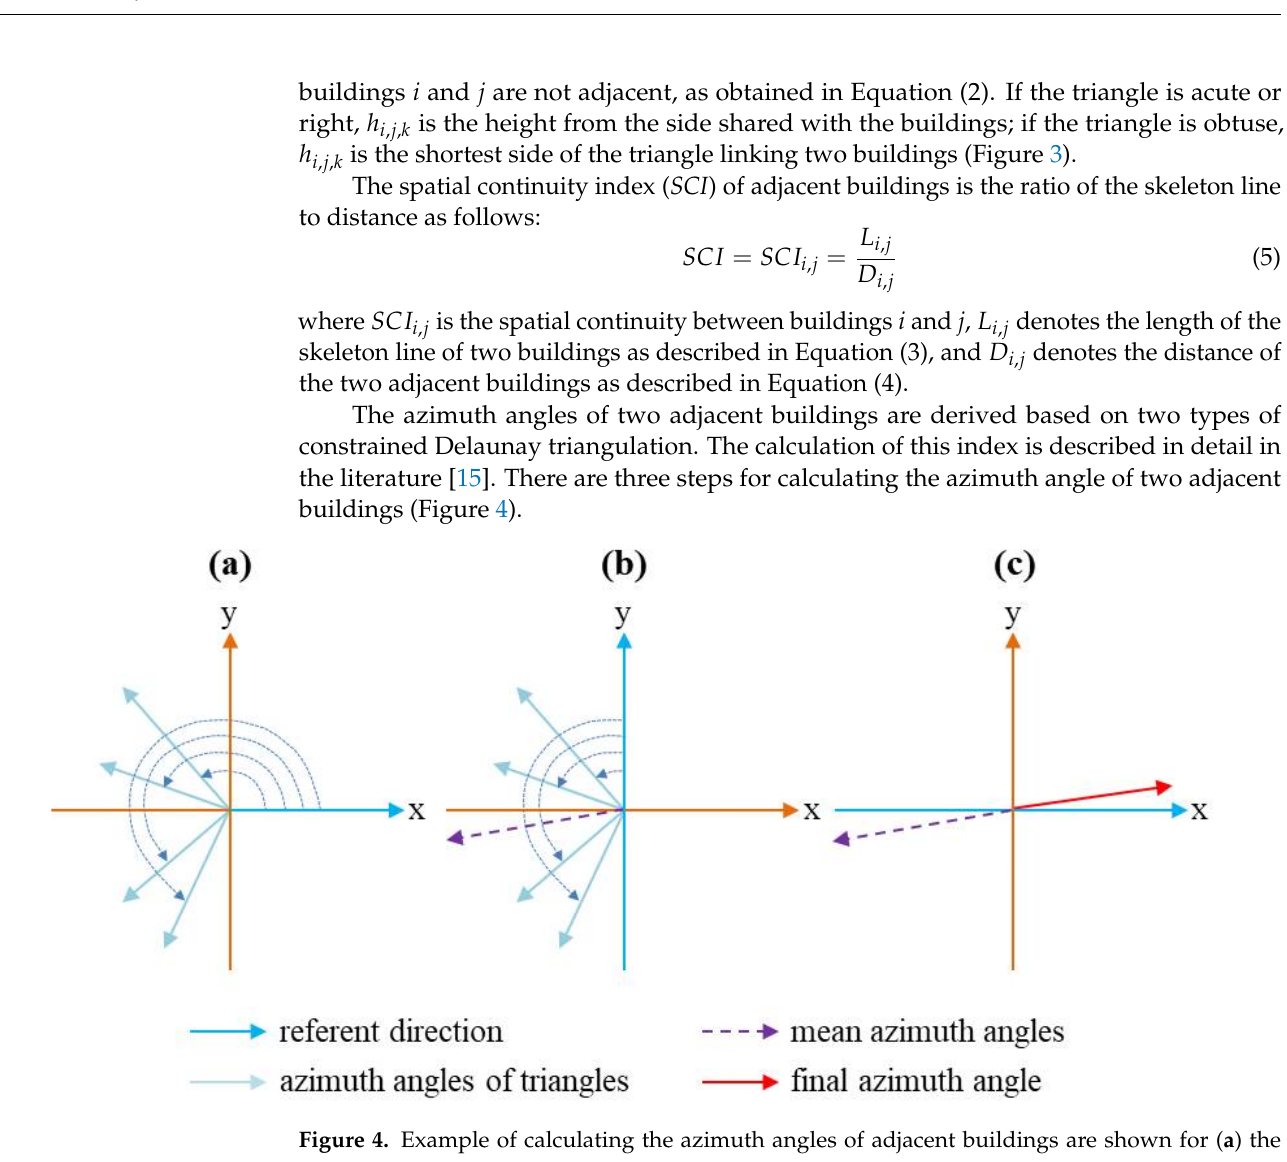
Figure 3. Example of the heights and skeleton lines of adjacent buildings.